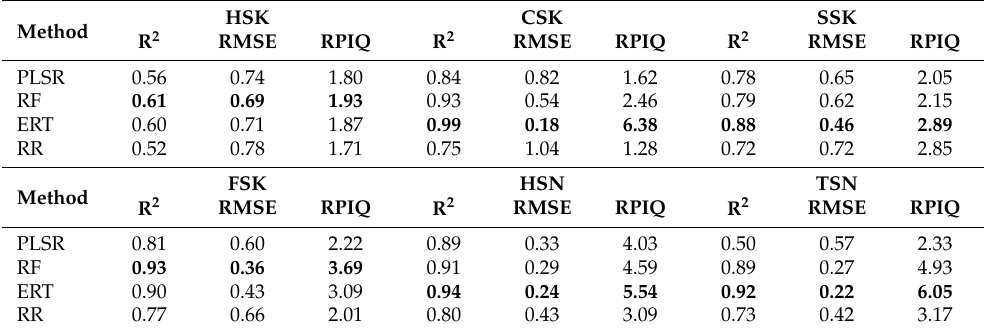
Table 4. Inversion model of soil EC value based on hyperspectral data.